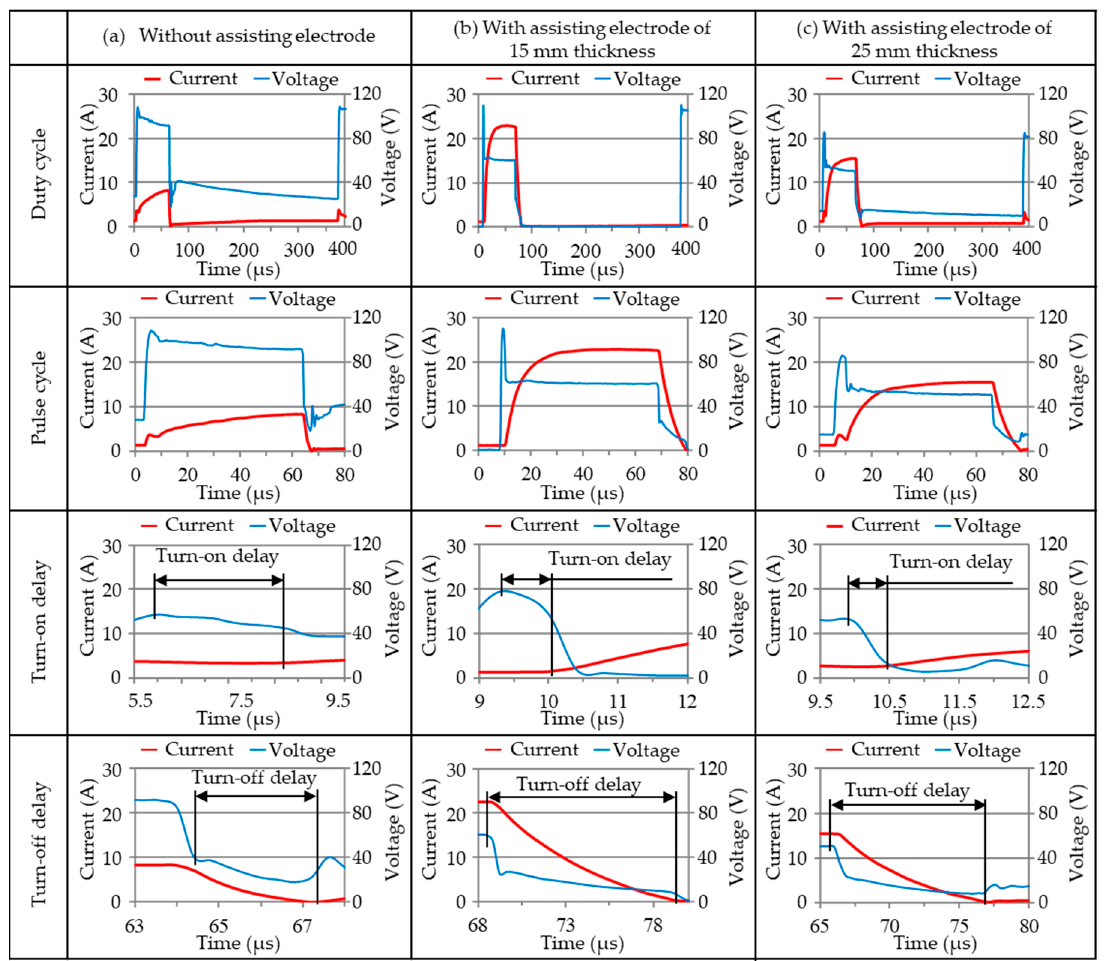
Figure 5. Measurements of discharge waveforms in WEDM of silicon workpieces using assisting electrodes of various thickness: ( a ) none; ( b ) 15 mm; ( c ) 25 mm, under the operating condition of 100 V, 1.7 Ω , and 60- μ s pulse-on time.